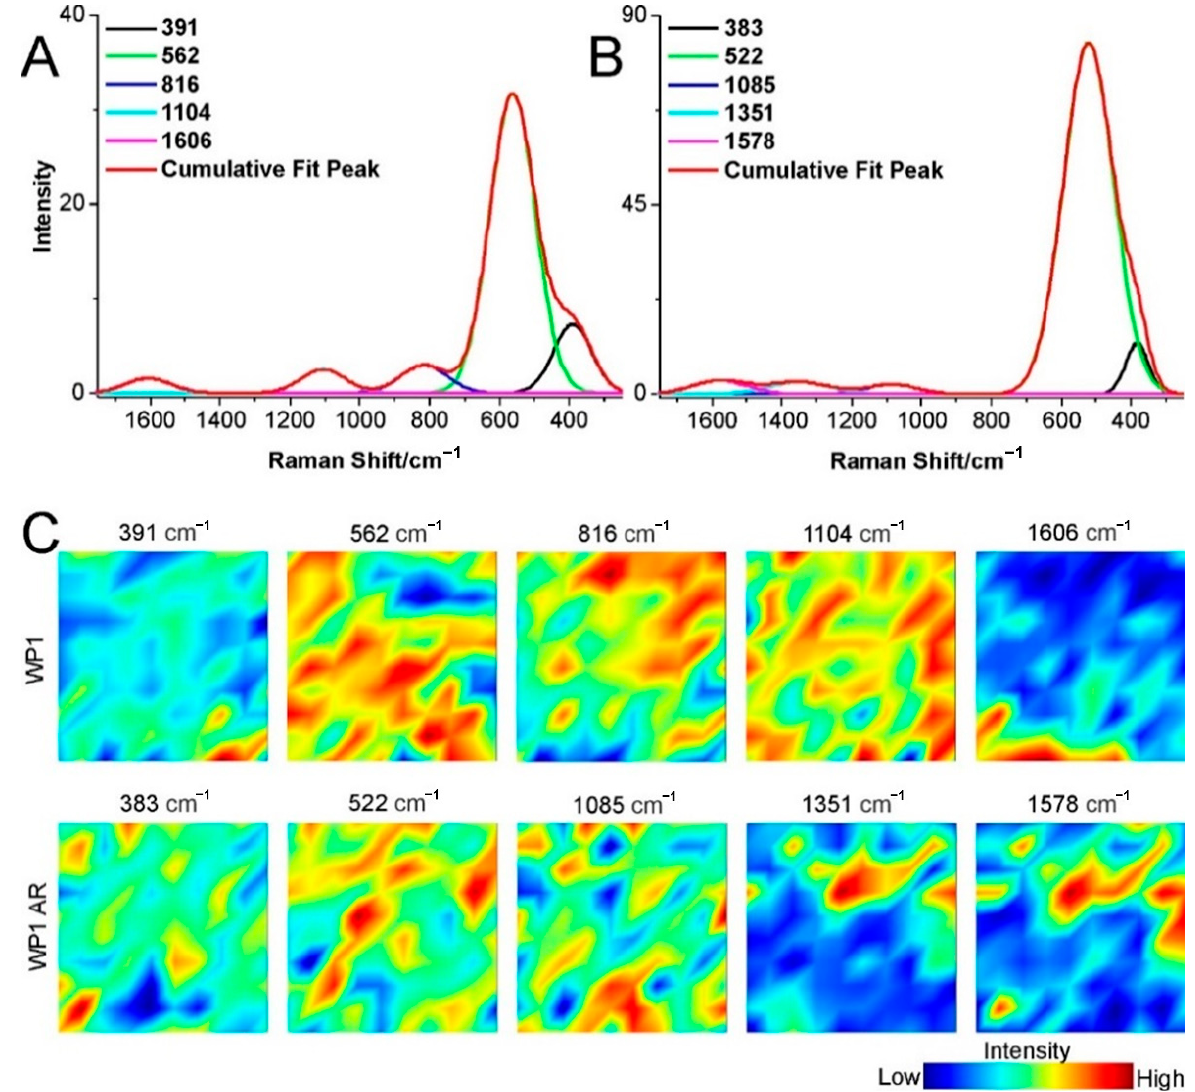
Figure 7. Deconvoluted Raman spectra of the WP1 ( A ) before and ( B ) after the reaction. ( C ) Raman maps with the distribution of selected WP1 bands (top row) before and (bottom row) after the reaction. Red spectra correspond to the cumulative spectrum consisting of the deconvoluted bands. Other colors of spectra correspond to the single deconvoluted bands.